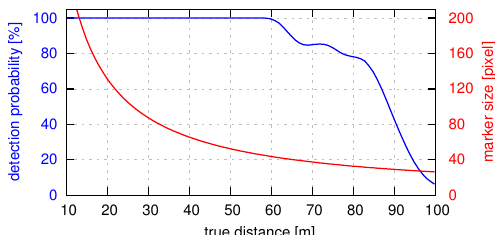
Figure 8: Estimate of the detection probability as a function of the true distance from the camera.